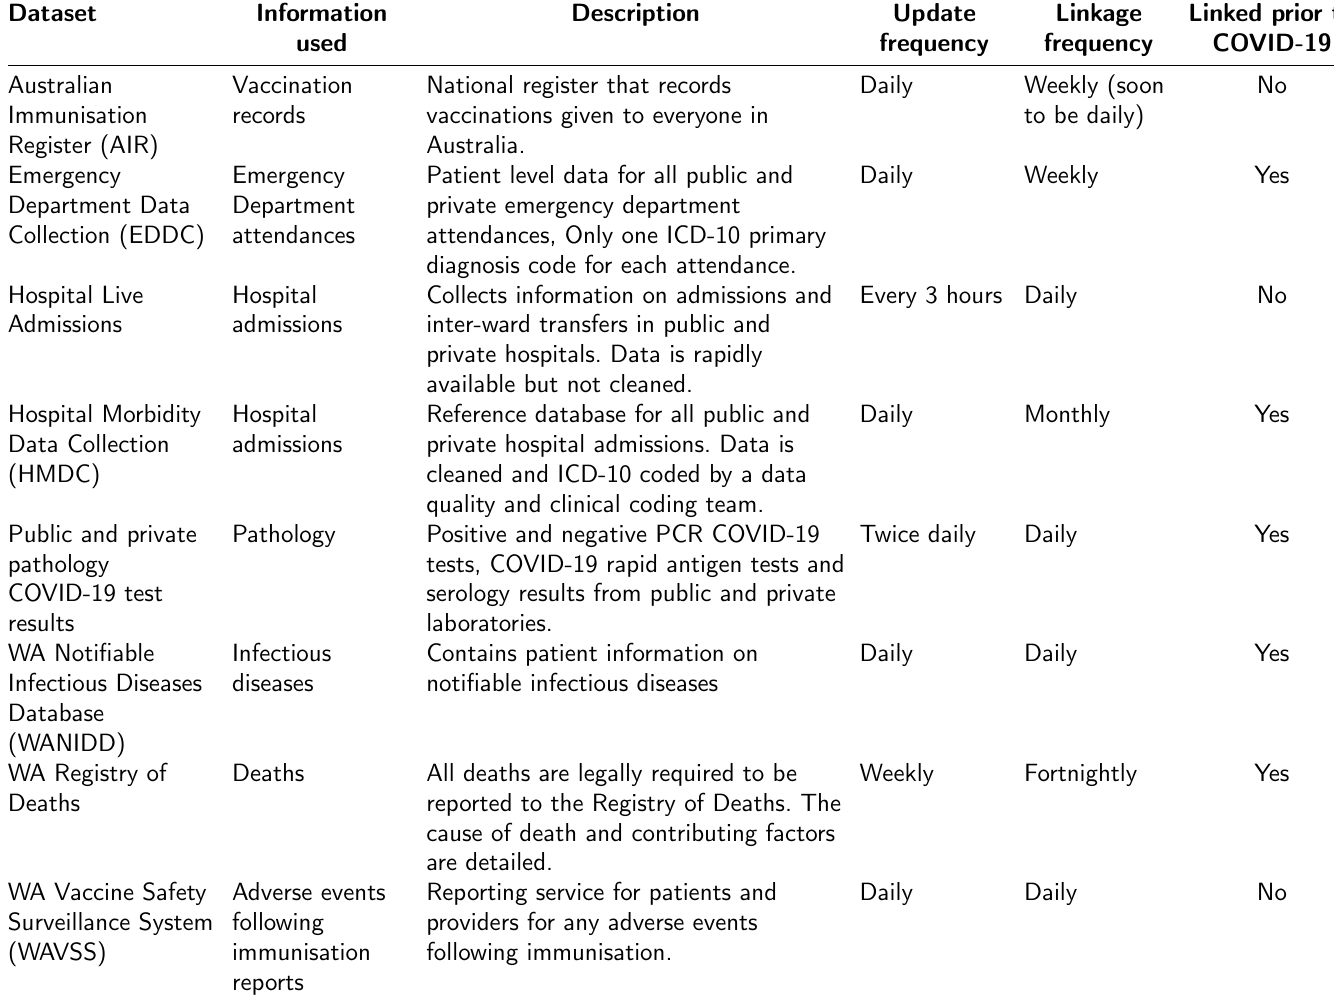
Table 1: Datasets held in the COVID-19 Vaccination Linked Data Repository